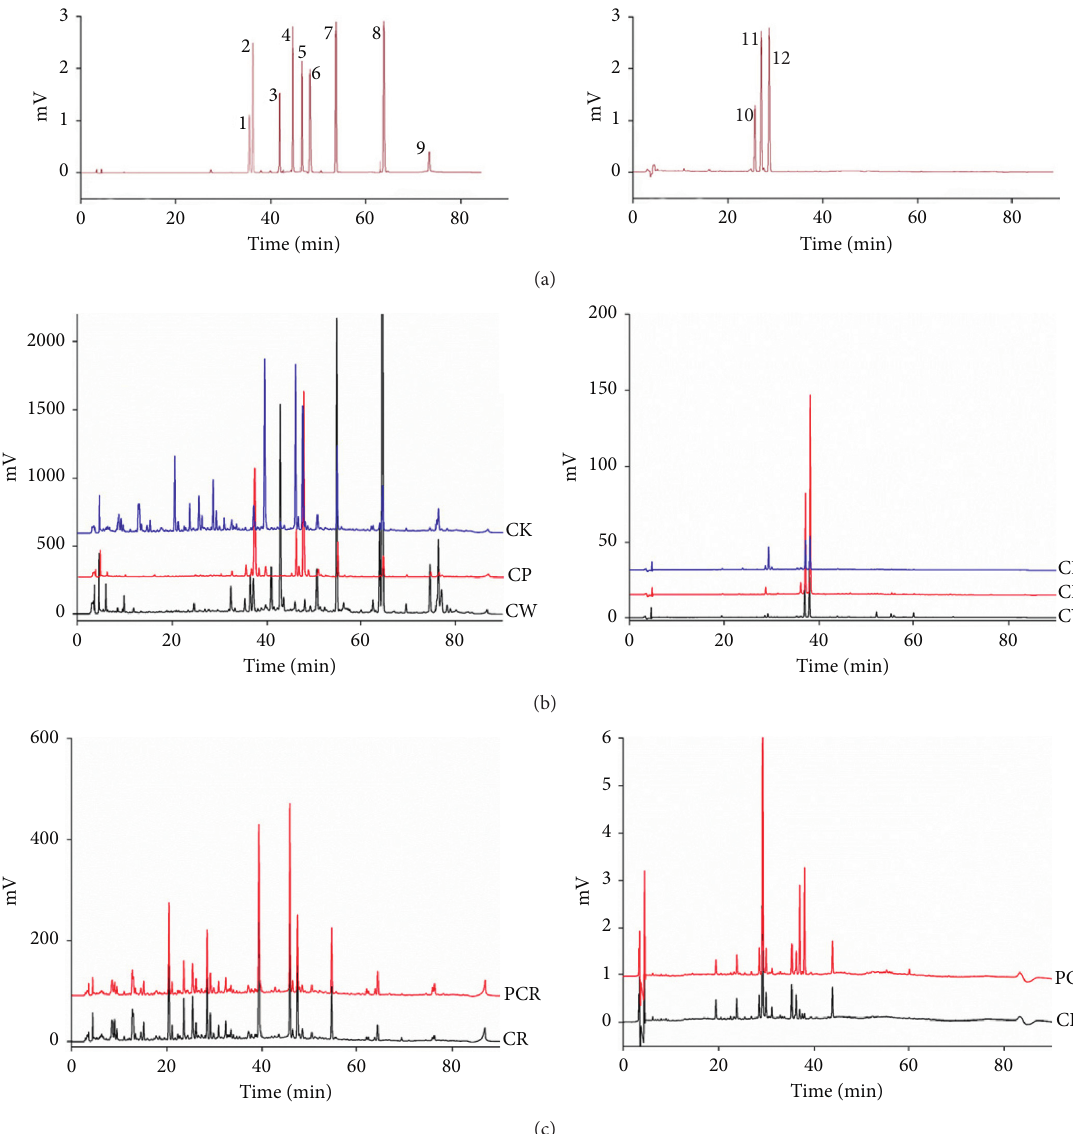
Figure 2: Representative chromatograms of standard substances (a) and samples (b, c) at 210nm and 415nm. Peaks 1 ∼ 12 refer to curcumenol, curzerene, curdione, isourecumenol, furanodienon, curcumol, germacrone, furanodiene, β -elemene, bisdemethoxycurcumin, demethoxycurcumin, and curcumin,